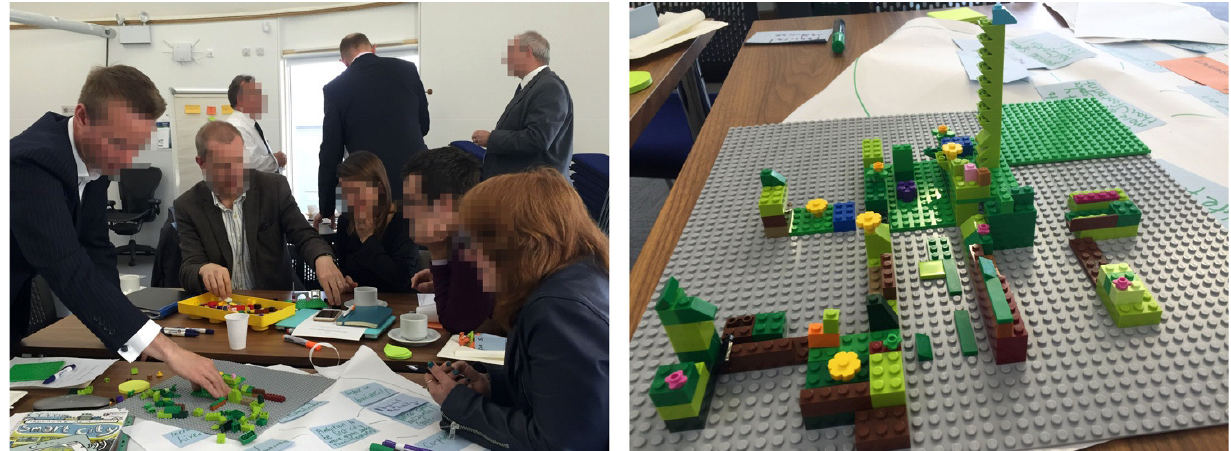
Figure 2. Participants during LEGO® mash‐up and project idea outcomes built as LEGO®